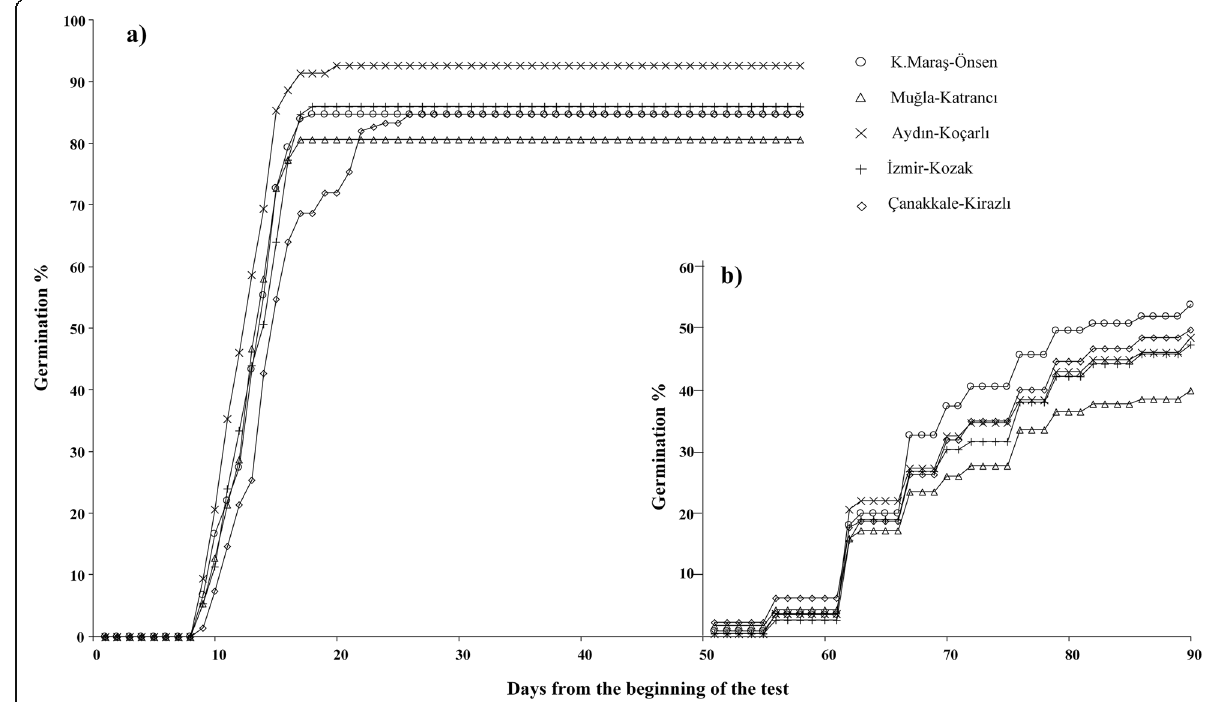
Fig. 3 Germination of P . pinea seeds from five natural populations in a the growth chamber (20 °C) and b the field